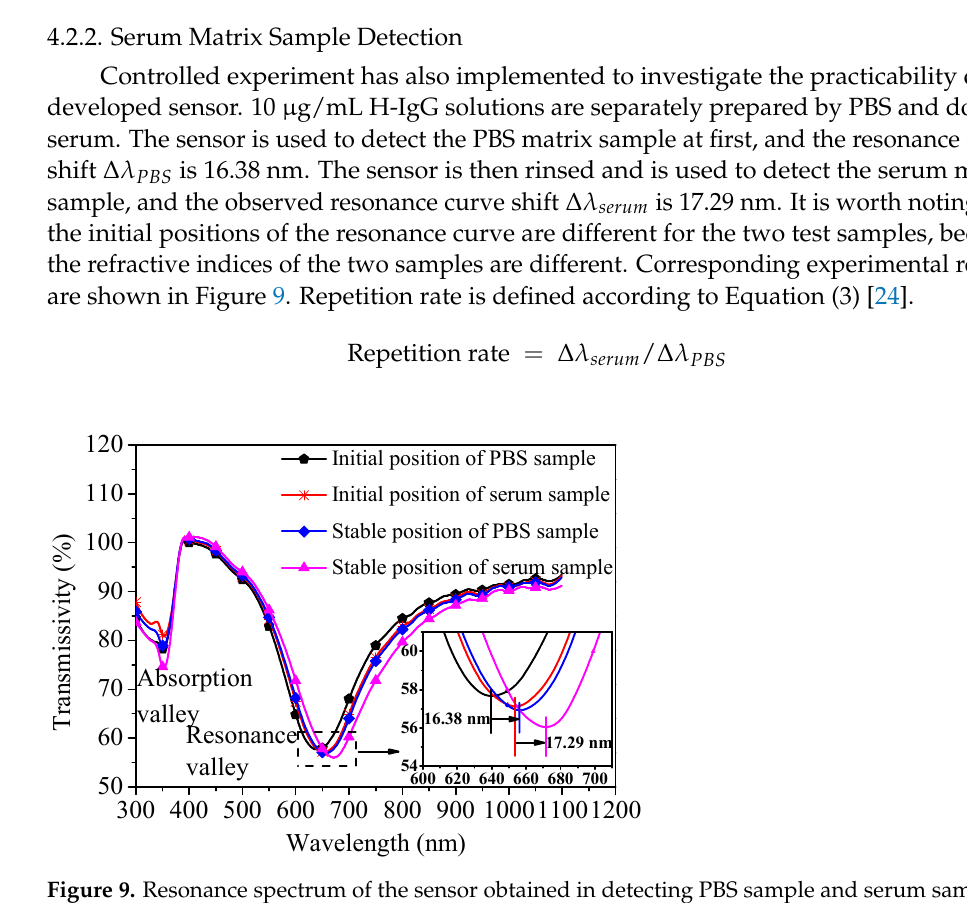
Figure 8. The ( a ) specificity and ( b ) repeatability of the sensor. Error bar = ±S.D., and the same assay in the same experimental conditions is repeated three times.